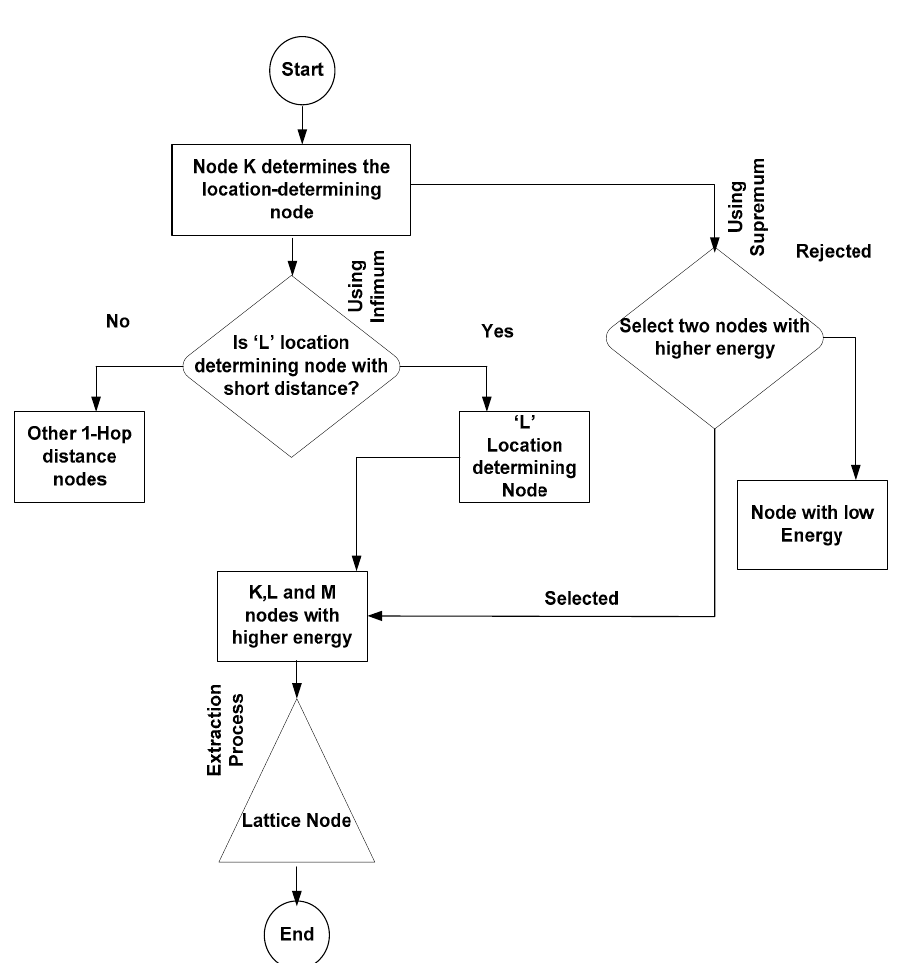
Figure 1. Lattice node selection process based on infimum and supremum properties.